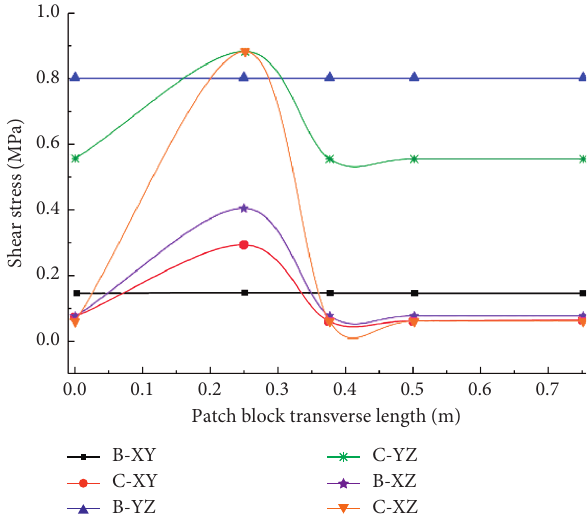
Figure 8: The effects of lateral movement of different loading positions on shear stress of joint filling material.